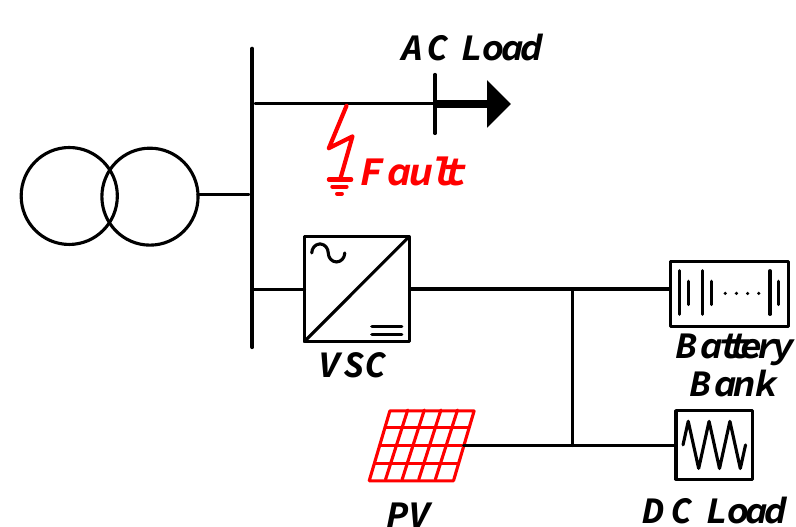
Figure 1. Schematic of Power Distribution System connected with DC Power System.